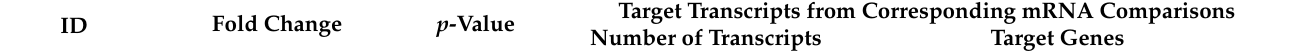
Table 2. Pathological miRNAs in the LV of DCM hearts and their corresponding target